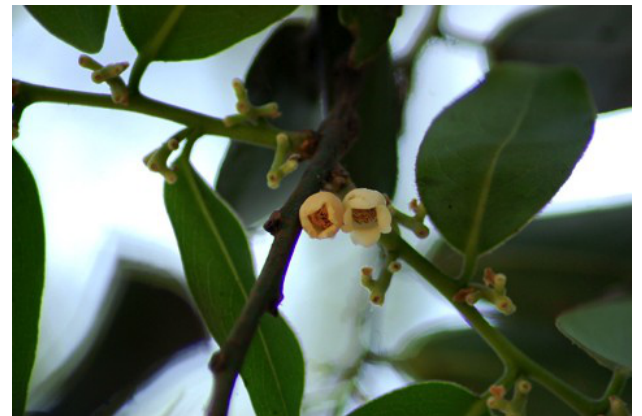
Figure 1. Diospyros peregrina (syn. D. malabarica )